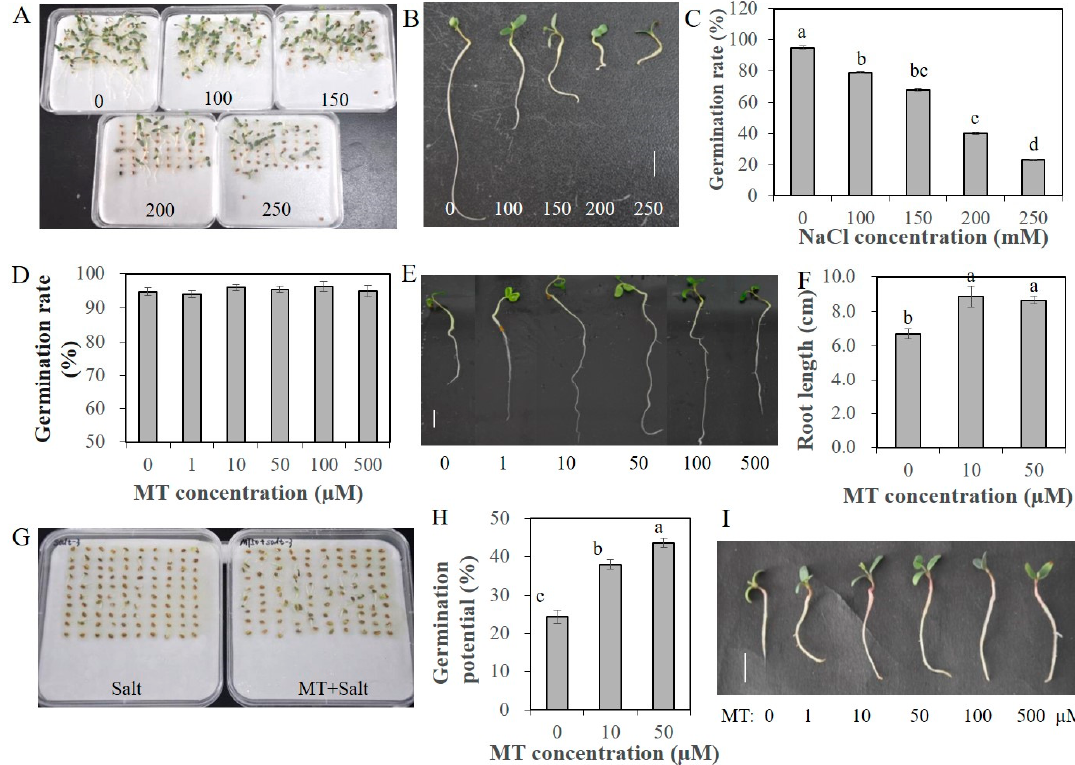
Figure 1. Germination status of alfalfa seeds under various concentrations of salt and melatonin (MT). ( A ), Alfalfa seeds germinated under salt stress with various concentrations of NaCl (0, 100, 150, 200 and 250 mM) for 7 days; ( B ), Seedlings after being germinated under di ff erent concentrations of NaCl (0, 100, 150, 200 and 250 mM) for 7 days; ( C ), Germination rates of alfalfa seeds germinated under various concentrations of NaCl (0, 100, 150, 200 and 250 mM) for 7 days; ( D ), Germination rate of alfalfa seeds pretreated with various concentrations of MT (0, 1, 10, 50, 100 and 500 µ M) and germinated under normal conditions for 7 days; ( E ), Seedlings germinated under normal conditions for 7 days with di ff erent concentrations of MT (0, 100, 150, 200 and 250 mM) pretreatment; ( F ), Root length of alfalfa seedlings after being germinated under normal conditions for 7 days with several concentrations of MT (0, 10 and 50 µ M) pretreated; ( G ), Alfalfa seeds germinated under salt stress (200 mM NaCl) and salt stress with MT pretreatment (50 µ M MT + 200 mM NaCl) for 4 days; ( H ), Germination potential of alfalfa seeds with MT (0, 10 and 50 µ M) pretreated and germinated under salt stress with 200 mM NaCl for 4 days; ( I ), Seedlings germinated under 200 mM NaCl condition for 7 days with MT (0, 1, 10, 50, 100 and 500 µ M) pretreatment, scale bar, 1 cm. Data are represented as means ± SE ( n = 3), and bars with di ff erent letters indicate the di ff erences between these di ff erent treatment groups according to ANOVA analysis ( p < 0.05).